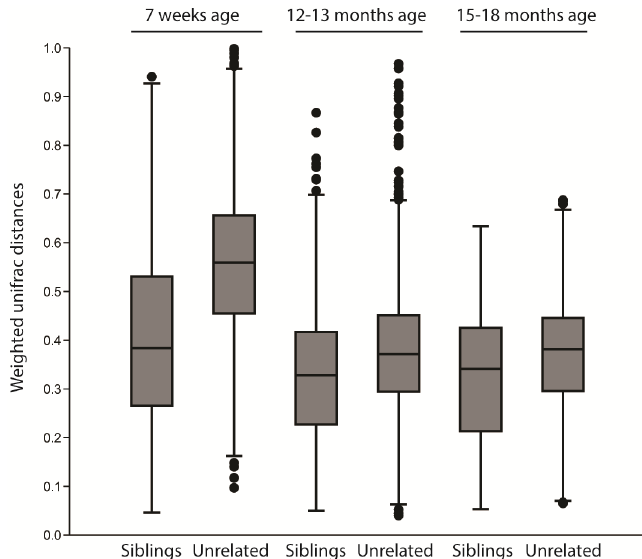
Fig 4. Boxplot showing the distribution of weighted unifrac distances comparing the microbiota between siblings and unrelated dogs at different ages. A distance of 0 represents an identical composition of the microbiota whereas 1 represents a total dissimilarity.